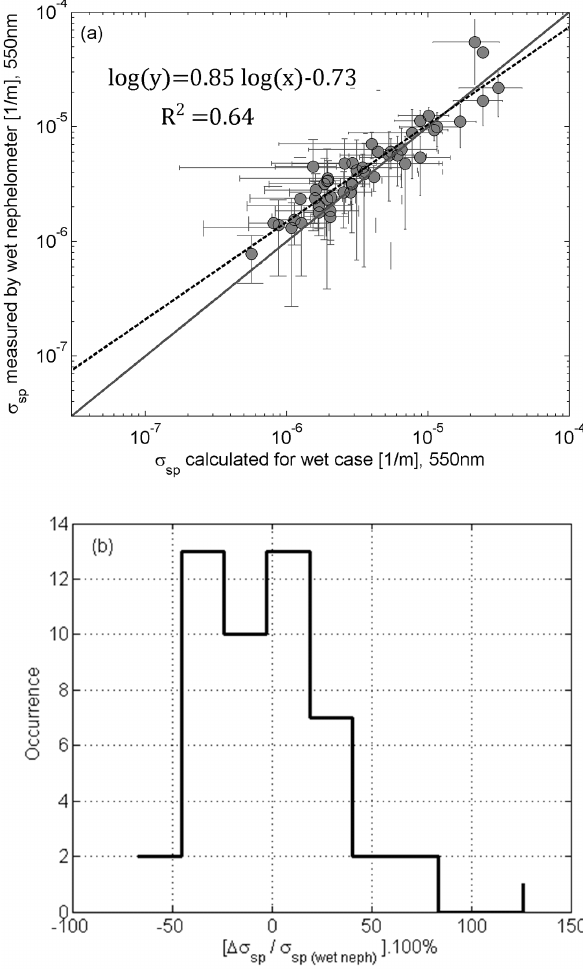
Figure 6. (a) Correlation between modeled and measured daily mean wet σ sp (550nm) at the ambient RH for the campaign (15 July–12 October 2008). The error bars indicate the standard deviations of the daily averages. (b) Histogram of the deviation of modeled scattering coefficient from measurements in percentage